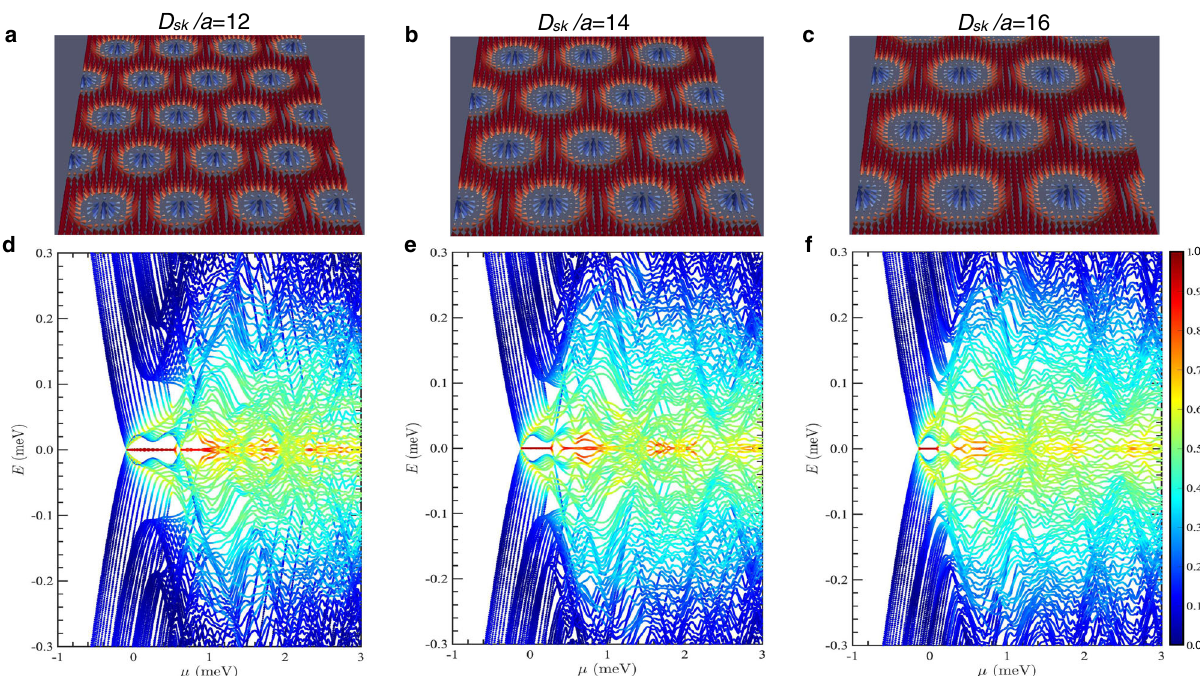
Fig. 3 Skyrmion control of the Majorana bound states. a – c The skyrmion crystals of different skyrmion diameters a D sk = 12 a , b D sk = 14 a , c D sk = 16 a , obtained in the Monte Carlo calculations using a a magnetic fi eld H z = 0.8 J , a Dzyaloshinskii-Moriya interaction strength D = 1.4 J , b H z = 0.45 J , D = J , and c H z = 0.23 J , D = 0.6 J . d – f The corresponding quasiparticle spectra of the planar Josephson junction at the phase difference φ = 0 with varying chemical potential, obtained by solving the Bogoliubov-de Gennes equations with the above skyrmion crystal spin con fi gurations. The colorbar in d – f represents the Majorana polarization j P M ; n j of the quasiparticle states.